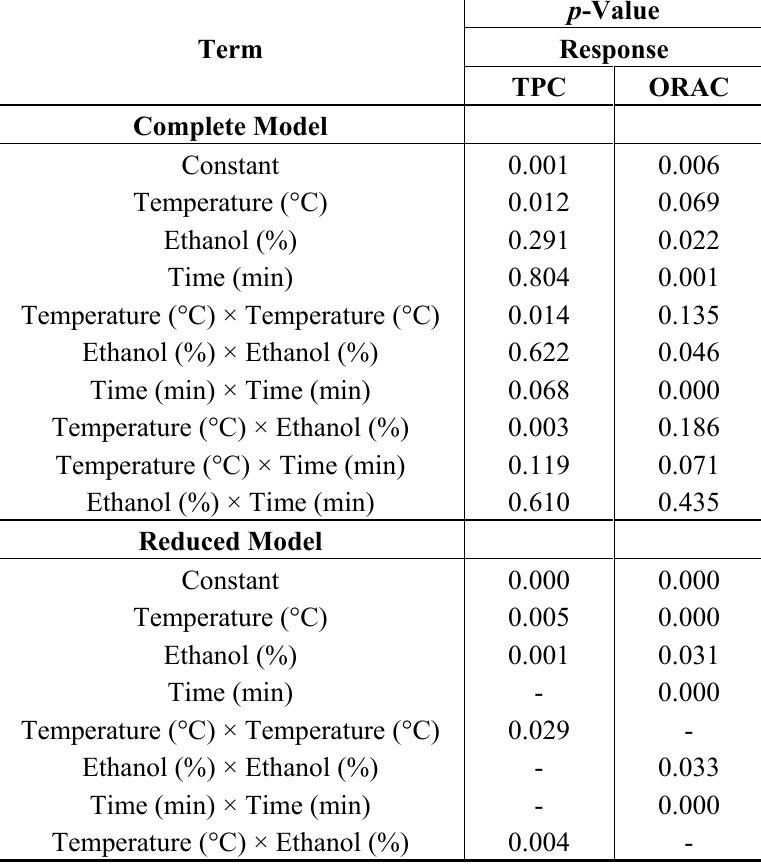
Table 2. p -Values for each of the constants in the equation of the mathematical model. p Term